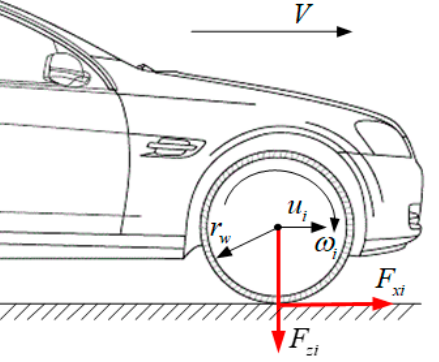
Figure 3. Single driving wheel model.